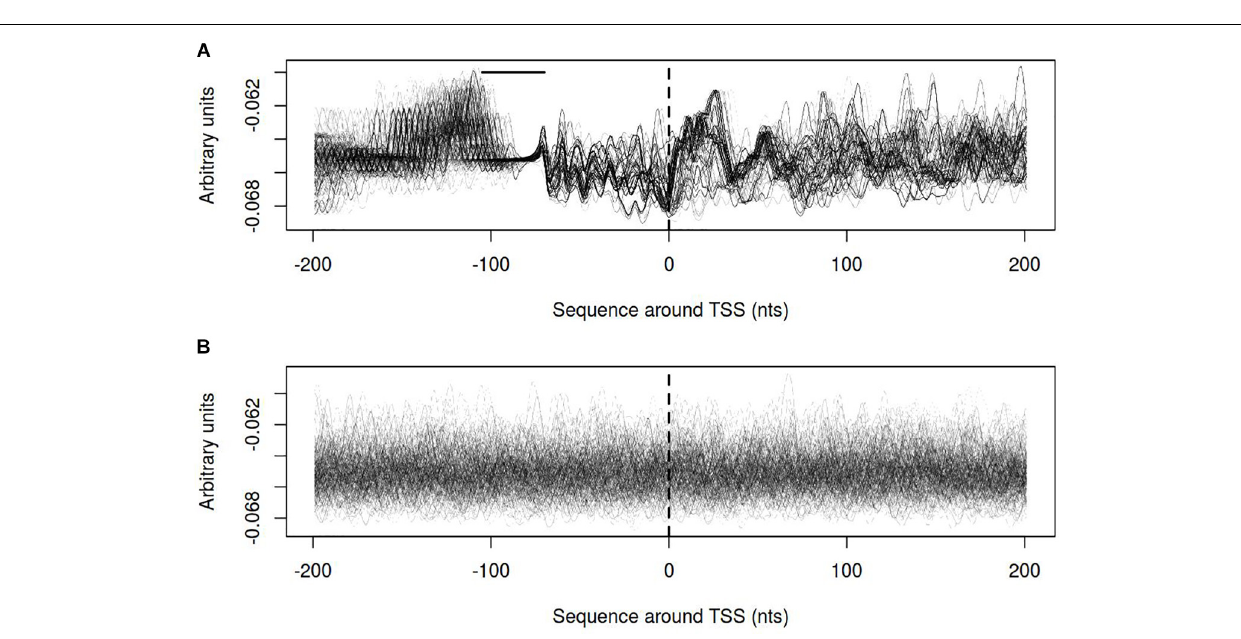
Most of the analyzed strains are isolated from wild birds and are pathogenic for the host. We observed 12-GAA vlhA genes occur more than one time in the genome. Obtained data implies that the presence of a single 12-GAA vlhA gene is not the only possible combination enabling pathogenicity